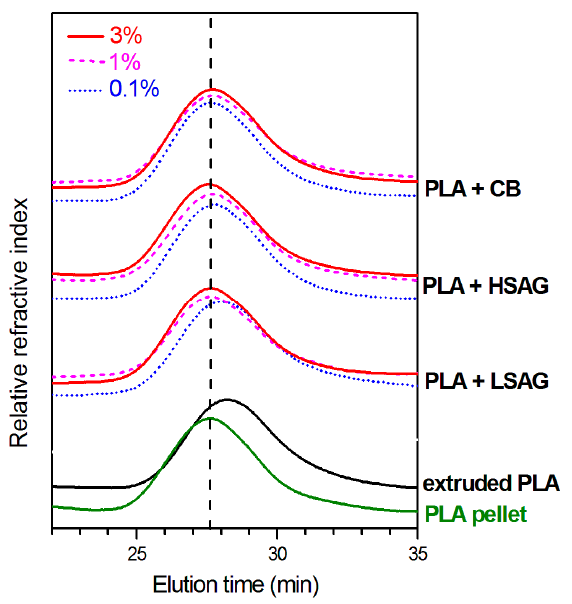
Figure 3. GPC curves in THF at 35 °C of the PLA pellet (green) of extruded PLA (black) as well as of extruded PLA compounds, as obtained by processes whose viscosity reduction is shown in Figure 2. Compounds contain 0.1 wt % (dotted lines), 1 wt % (dashed lines), and 3 wt % (continuous lines) of different graphitic fillers: LSAG, HSAG, and CB. Table 1. Number average molecular weight ( M n), weight average molecular weight ( M w), and polydispersity index (PDI) as evaluated by GPC curves, for PLA pellet and extruded compounds with LSAG, HSAG, and CB. The evaluated variance is of ±3 kDa.